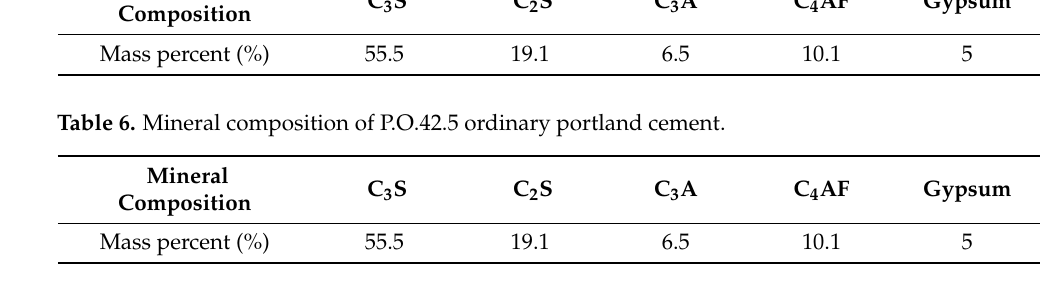
Table 6. Mineral composition of P.O.42.5 ordinary portland cement.